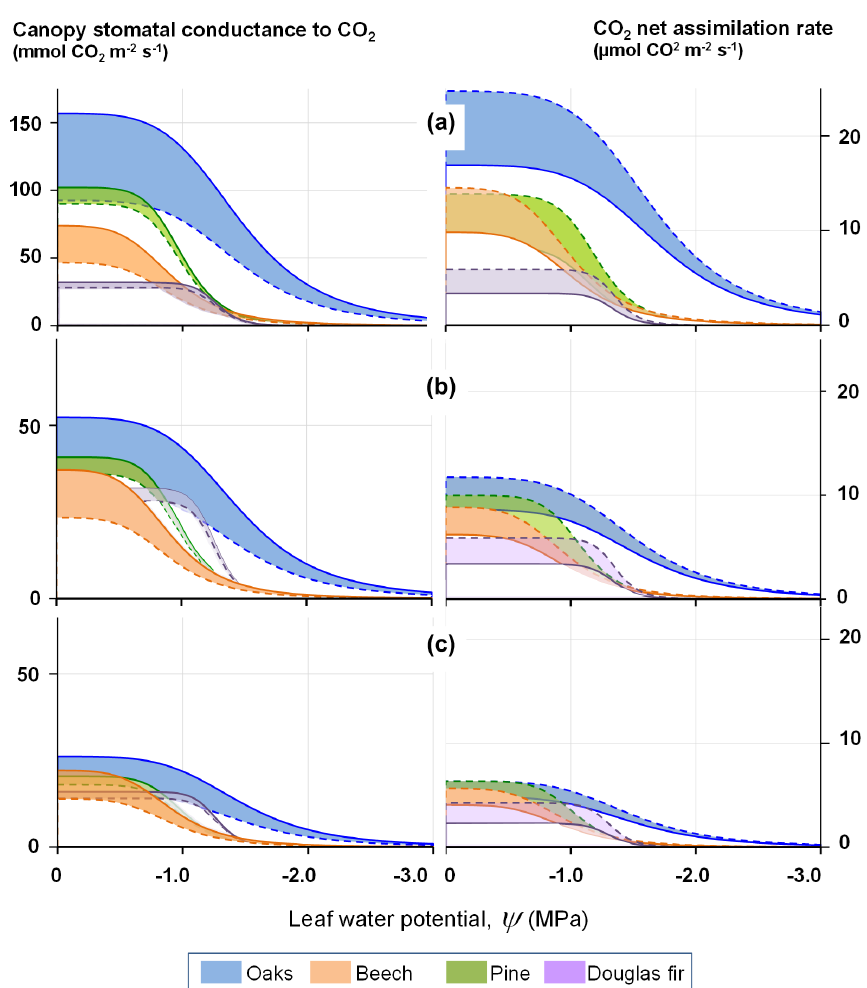
Figure 2. Modelled response of the stomatal conductance (left) and light-saturated photosynthesis (right) to decreasing leaf water potential at three levels of air water vapour saturation deficit, δe w : (a) 500Pa, (b) 1500Pa, (c) 3000Pa, according to Eqs. (13) and (22). The response curves delineate the range of response of four tree species for atmospheric concentrations of CO 2 varying between 410 (full line) and 820ppm (dashed